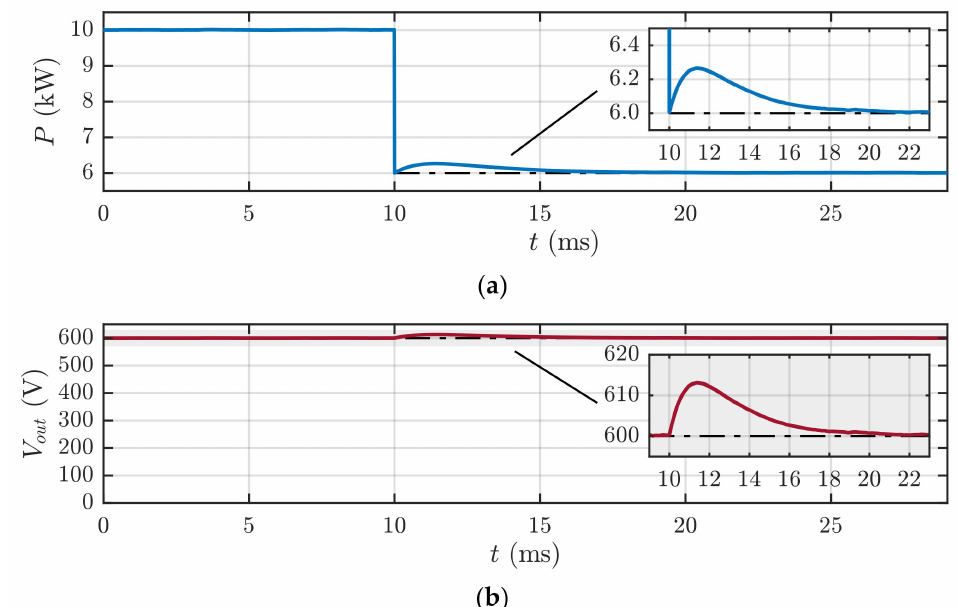
Figure 19. Real-Time HIL results ( a ) output power, ( b ) output voltage during load variation from 10 kW to 6 kW with the proposed control method.